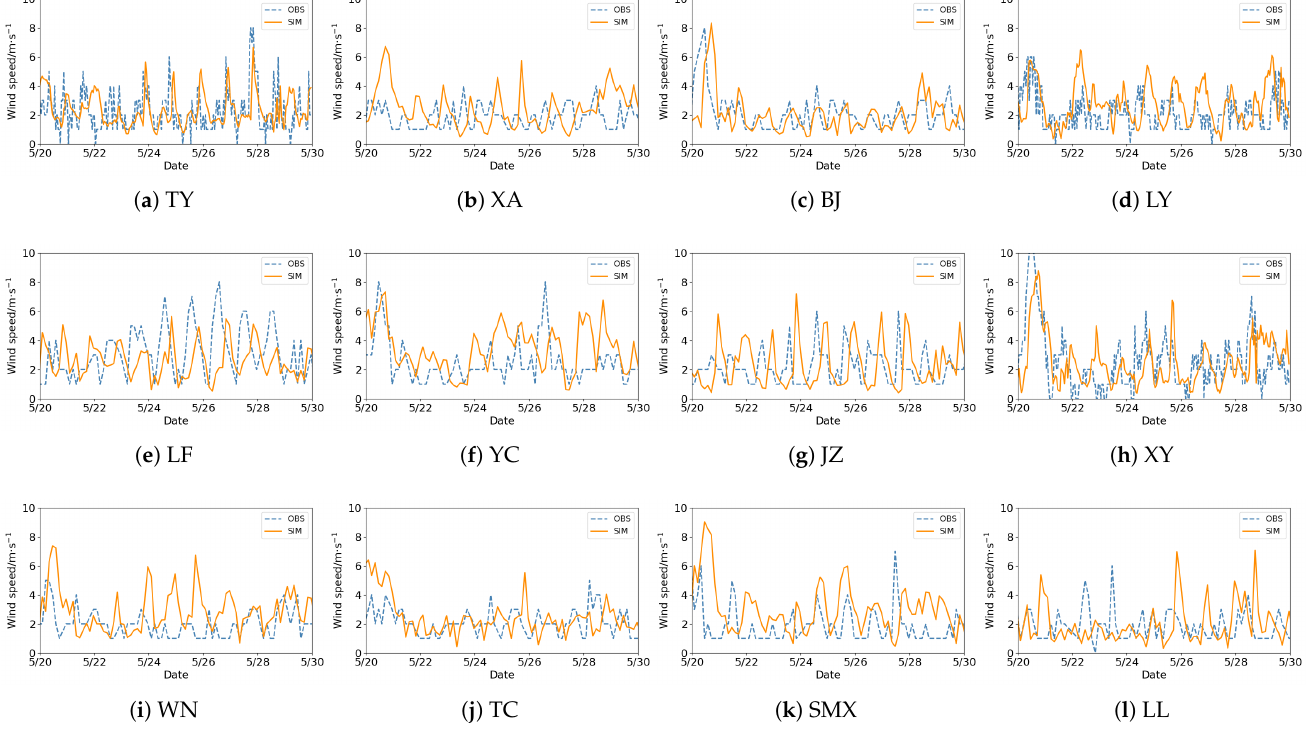
Figure 3. The observed and predicted wind speed at 10 m. Table 4. Assessment parameters for wind speed